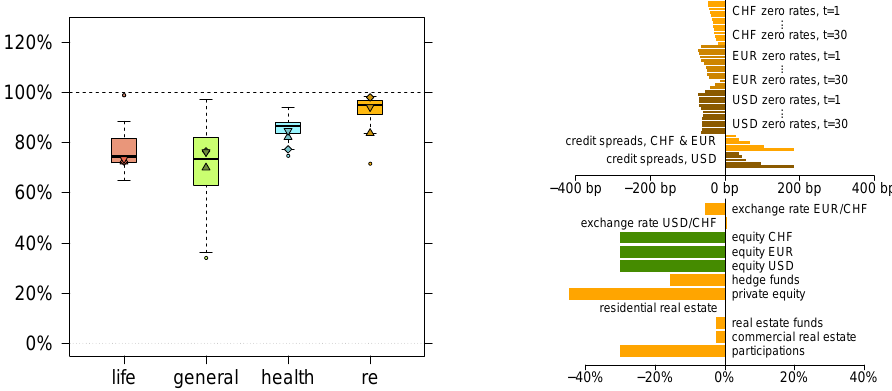
Figure 6. (rhs) illustrates the changes in market risk factors due to a fall of the equity market. The changes colored green are predefined, the changes colored orange result from market dependencies. (lhs) illustrates the resulting impact ratios (cid:36) i of the insurance companies, where (cid:78) , (cid:7) and (cid:72) correspond to the impact ratios of the first, second and third largest company, respectively, in each branch of